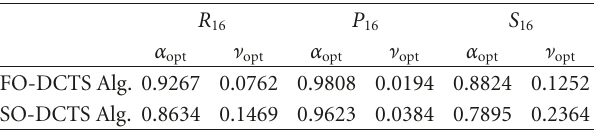
Table 1: Numerical results comparing convergence rates of FO- DCTS and SO-DCTS algorithms in R 16 , P 16 , S 16 . R 16